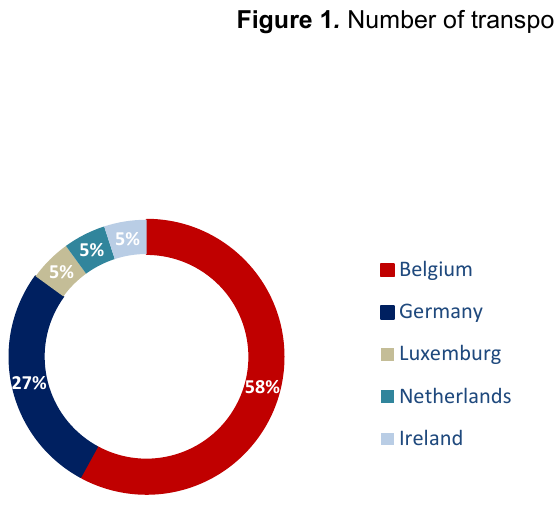
Figure 2. Residence country of the owner of letterbox transport companies in Slovakia